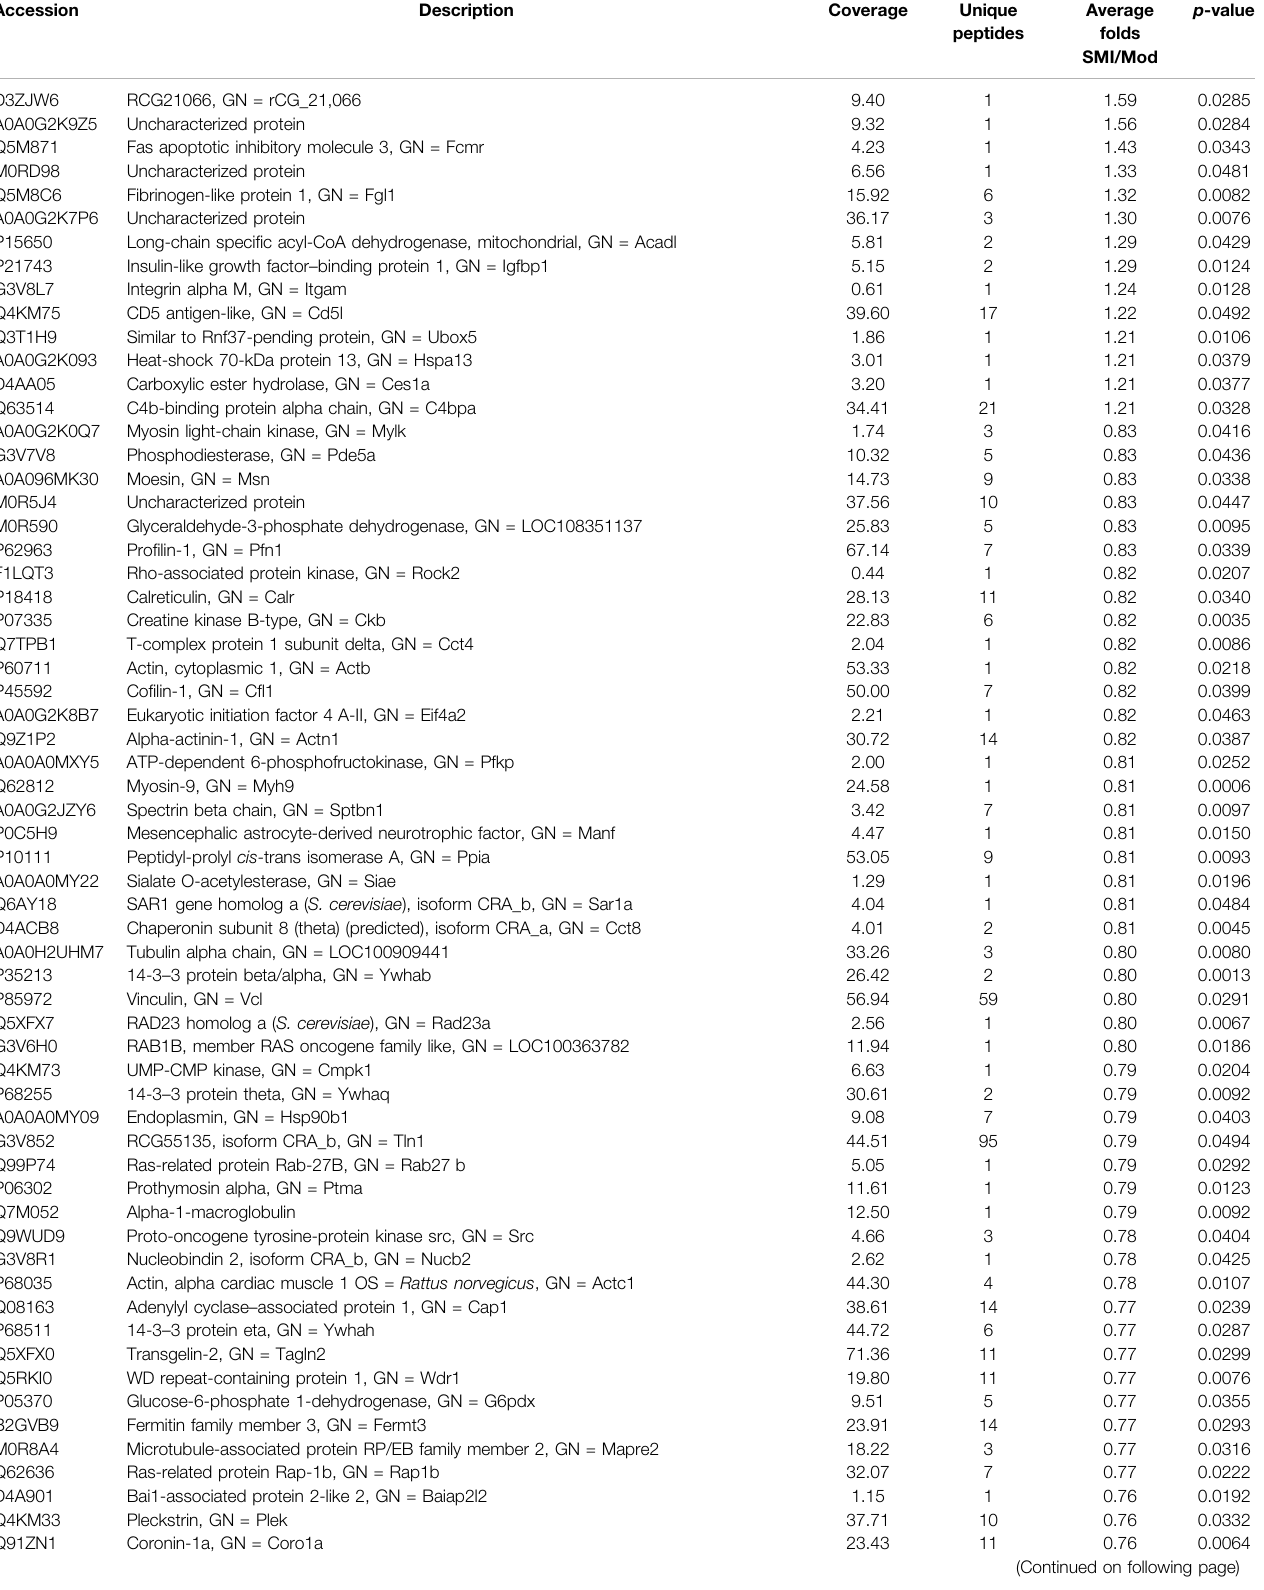
TABLE 2 | Signi fi cantly up- and downregulated serum proteins in SMI: Mod group rats.